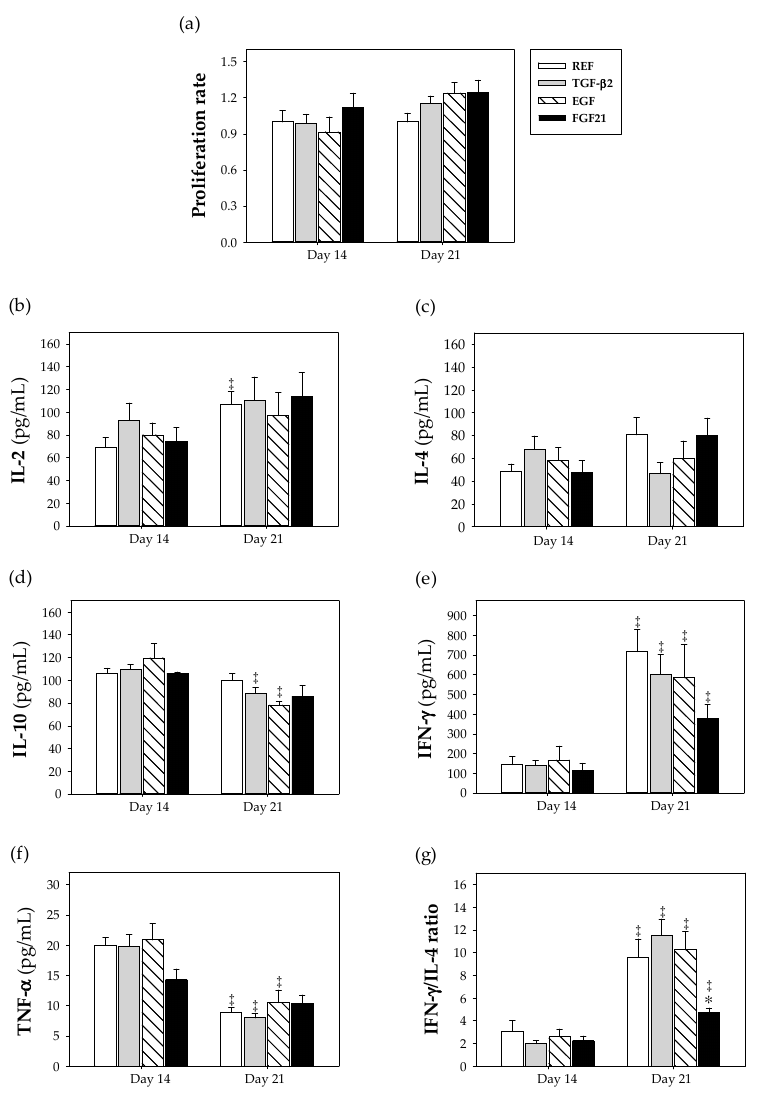
Figure 3. Effect of growth factor supplementation on proliferative response and cytokine production by spleen lymphocytes after in vitro mitogen-stimulation from the four groups, i.e., reference (REF), transforming growth factor- β 2 (TGF- β 2), epidermal growth factor (EGF) and fibroblast growth factor 21 (FGF21), over the suckling period (day 14 and 21). ( a ) Proliferation rate and cytokine concentration (pg/mL) of ( b ) IL-2, ( c ) IL-4, ( d ) IL-10, ( e ) IFN- γ , ( f ) TNF- α and (g) the IFN- γ /IL-4 ratio. Values are expressed as means ( n = 9 pups per group analyzed in quadruplicate or duplicate for proliferation assay or cytokine secretion, respectively) ± S.E.M. Statistical differences: * p < 0.05 vs . REF group; ‡ p < 0.05 vs. same group at day 14.